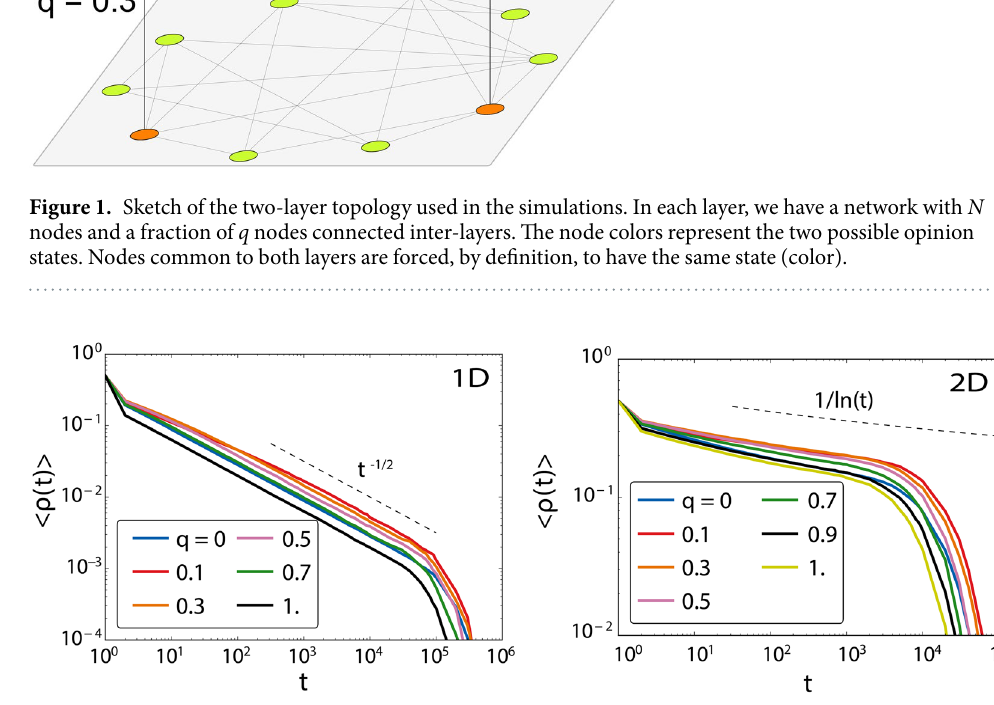
Figure 2. Temporal evolution of the average fraction of active links for different values of q . Left: One dimensional lattice of size N = 1000. Right: Two dimensional lattice of size N = 100 2 . In both cases, the averages are taken over 1000